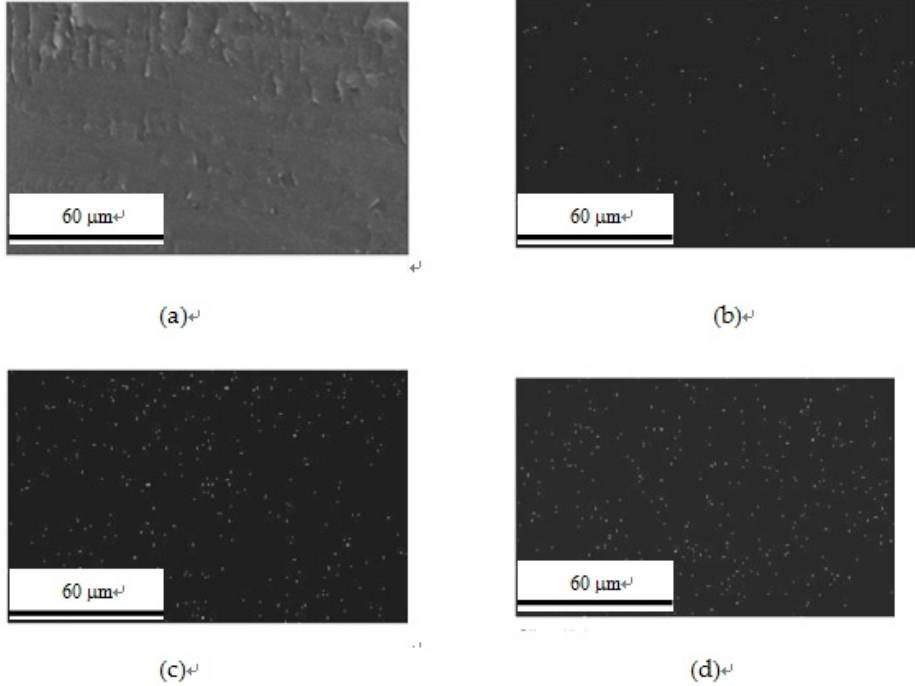
Figure 13. Energy dispersive X-ray spectroscopy(EDS) mapping micrographs based on the Si atom for the composite membranes with different nano SiO 2 contents: ( a ) 0%, ( b ) 1%, ( c ) 10%, ( d ) 20%.